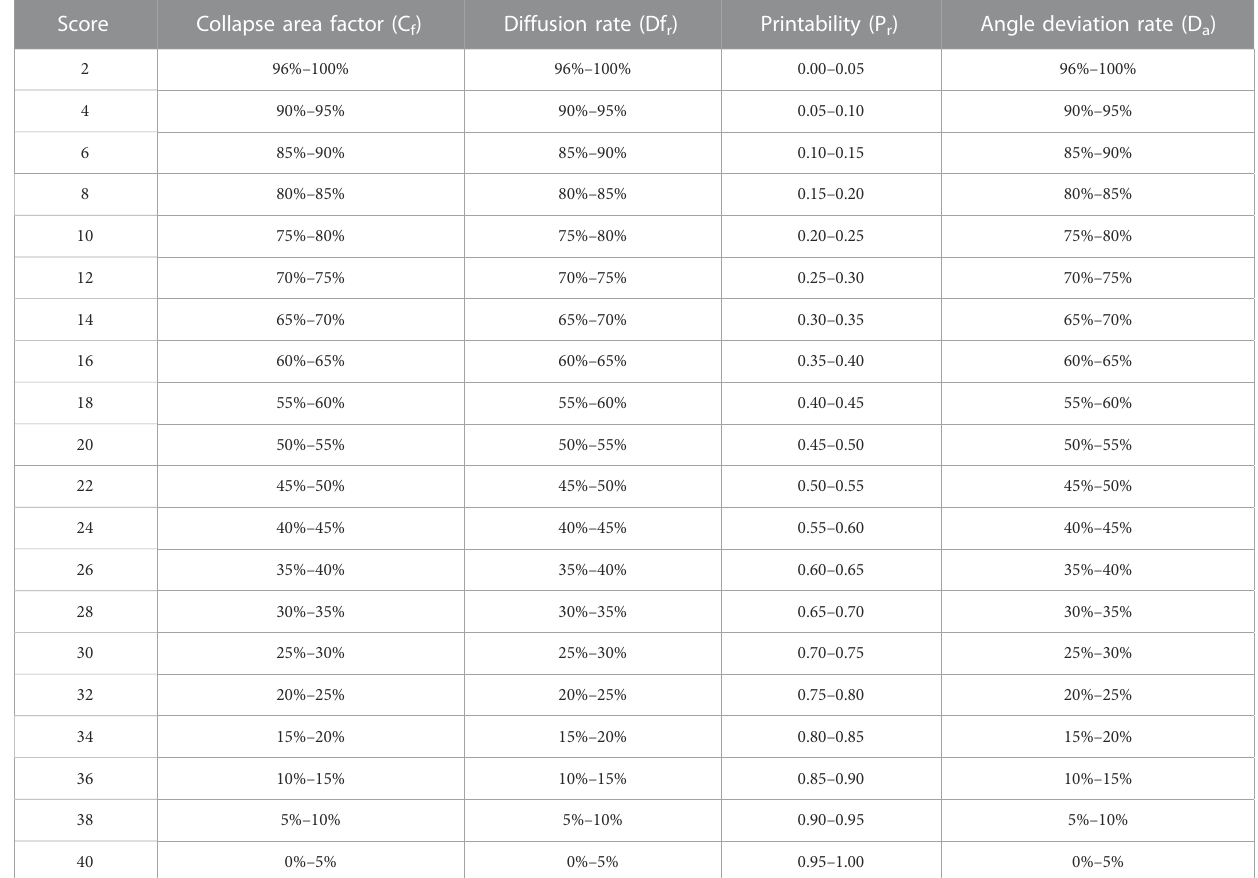
TABLE 1 Scoring table of the individual printing properties such as collapse area factor, diffusion rate, printability, and angle deviation rate. Score Collapse area factor (C f